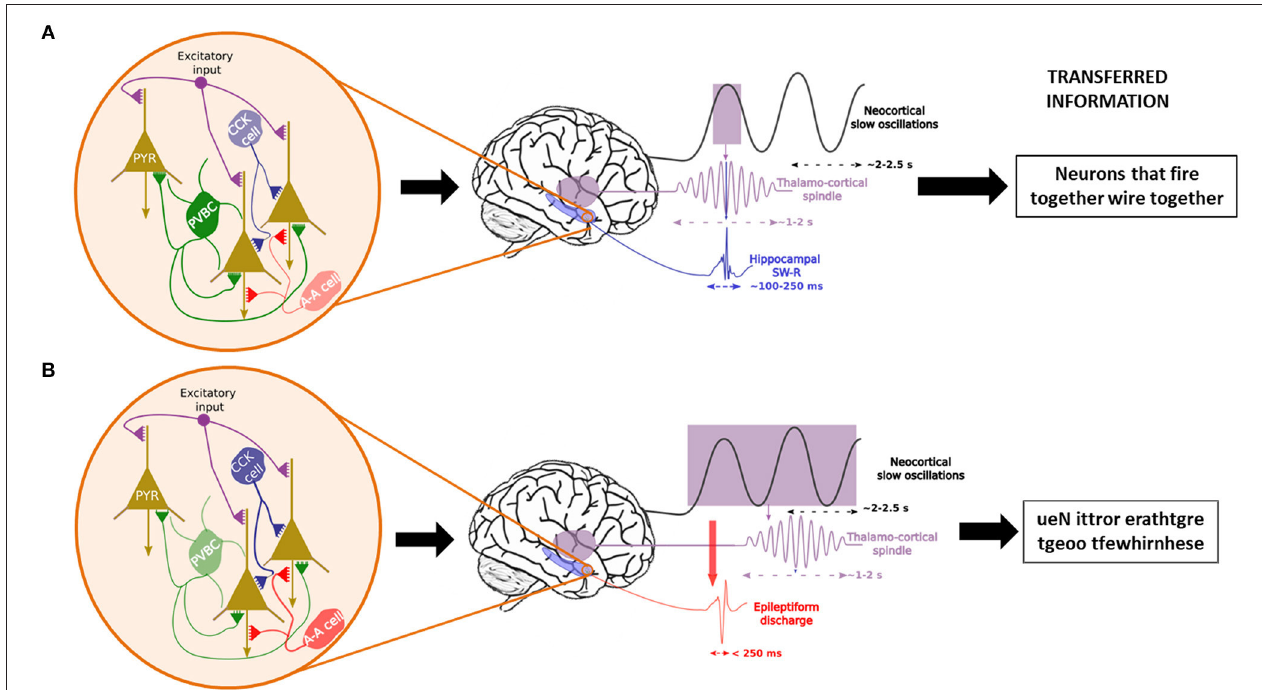
FIGURE 3 | Temporal control of sleep-related oscillations and their disruption in case of interneuronal dysfunction. In physiological conditions (A) , Parvalbumin-positive basket cells (PVCB) are the main regulator of the firing patterns of pyramidal cells (PYR) in the hippocampus, leading to the generation and control of sharp-wave ripples (SW-R) nested in the trough of sleep spindles, themselves time-locked to the ascending phase of neocortical slow oscillations. This enables the transfer of correct information packets to the “long-term memory stores” from the temporary hippocampal reserve. In case of PVBC dysfunction (B) , other interneurons (CCK cells = Cholecystokinin interneurons, A-A cells = Axono-axonic cells) try to compensate for the diminished inhibitory tone. Nonetheless, they are insufficient due to their more distal synapses on PYR cells. This leads to uncontrolled excitation and epileptic events that may induce spindles ( 161) which leads to the consolidation of nonsense